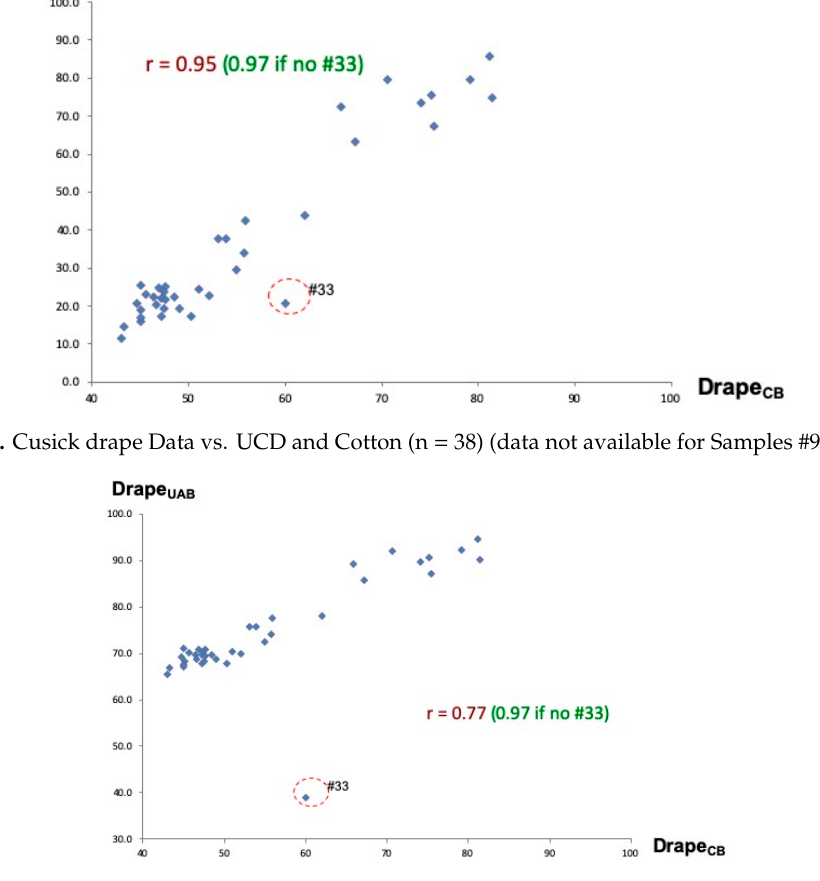
Figure 7. PhabrOmeter Drape and Cotton Cusick data (n = 38) (sata not available for Aamples #9 and #10). In discussing the outliers, it is noted that, according to the figures, in addition to #33 and #39, #9 in Figure 8 may also be problematic. As shown in Table 5, #9 is a 100% cotton twill, but careful examination found that there seems to be some coating or special finish on its surface to render it more rigid than Samples #1–#8, otherwise identical fabrics of 100% cotton twill. As there is no Cusick data for #9 from Cotton Inc., #9 only appears once in Figure 8 where all 40 fabrics were involved, and thus there is insufficient information to further examine #9. Sample #33 is a single knit Inlay fabric